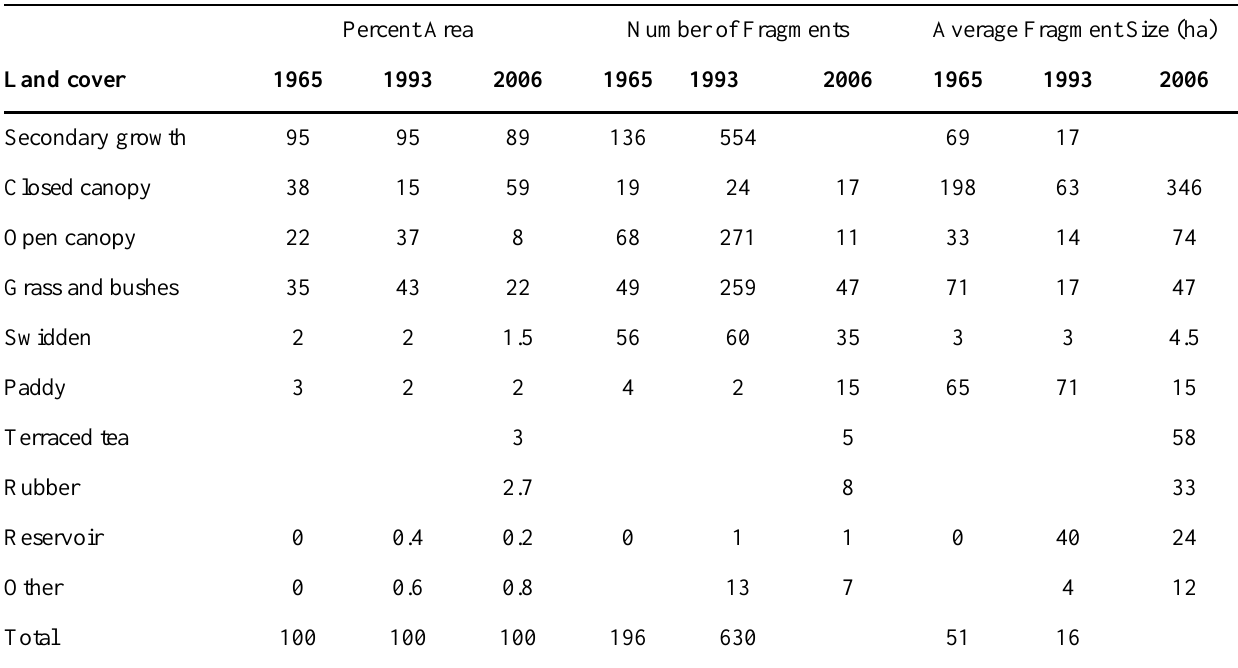
Table 2. Land-cover and fragmentation statistics in Mengsong in 1965 and 1993 (interpreted from aerial photographs (1965), Landsat TM (1993), and Spot (2006) images). Total area = 9965